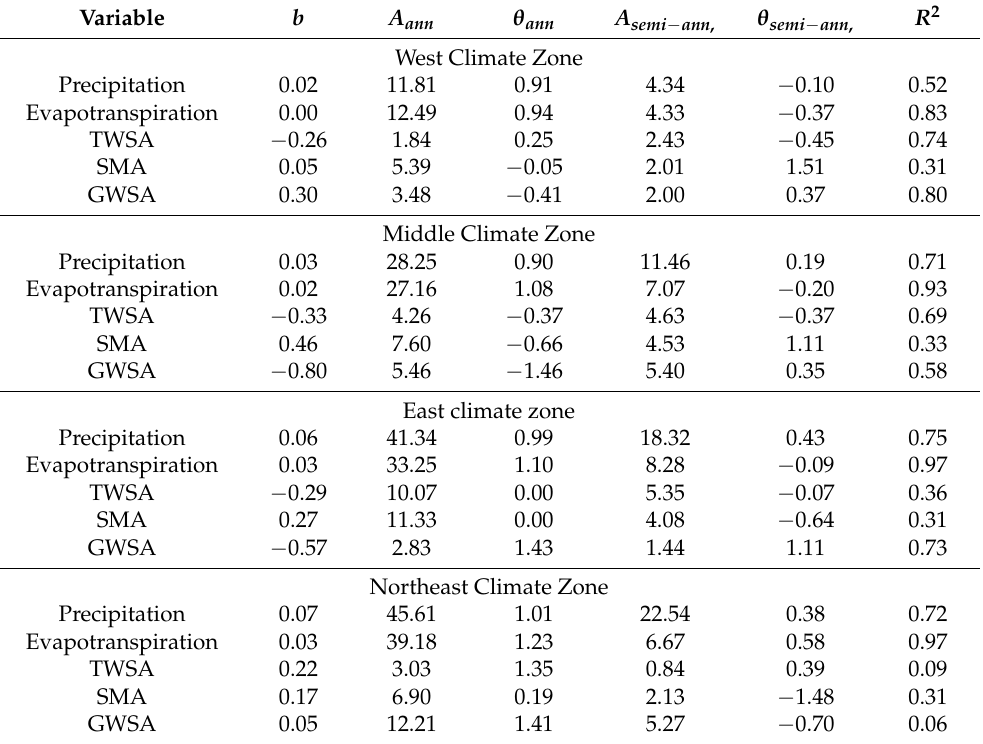
Table 1. Decomposition of TWSA and its hydrological components with precipitation and evapotran-